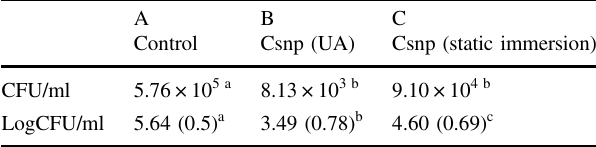
Table 1 CFU of Csnp-pretreated dentin surfaces against E. faecalis A